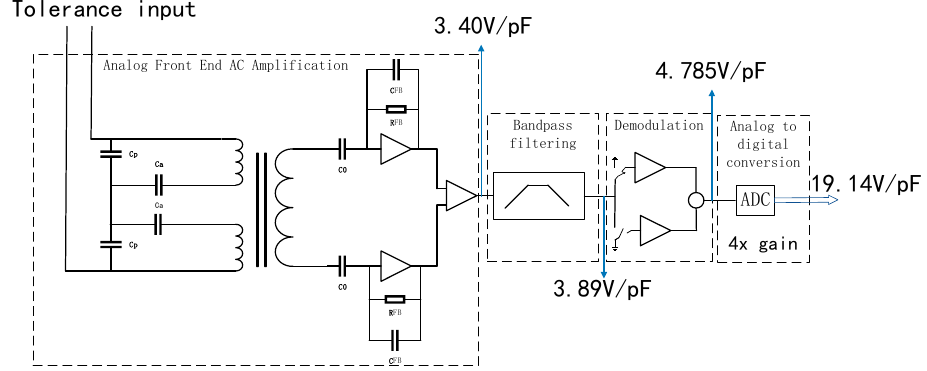
Figure 15. Gains of each functional module of the capacitive sensing system.